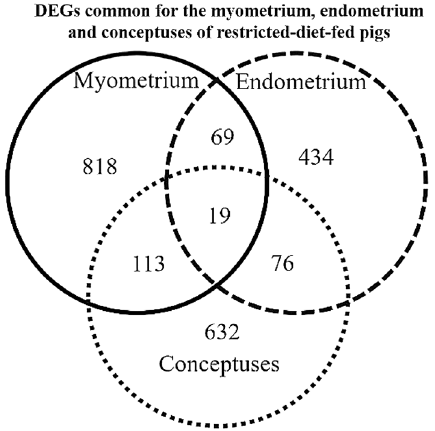
Figure 2. Venn diagram presenting the differentially expressed genes (DEGs) common for the myometrium, endometrium, and embryos collected from pigs during the peri-implantation period that were fed a restrictive diet during the peri-conceptional period compared to pigs fed a normal diet. Diagram generated with the use of online tool available at http:// bioin forma tics. psb. ugent. be/ webto ols/ Venn/, with further modifications.